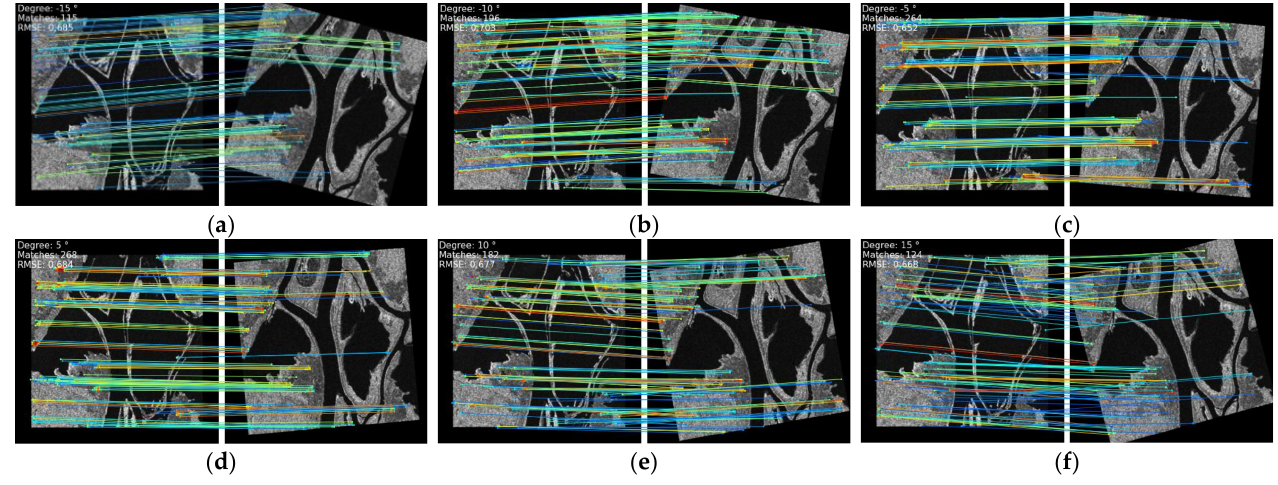
Figure 12. The registration performance of SAR images at varying rotations: ( a ) –15°, ( b ) –10°, ( c ) –5°, ( d ) 5°, ( e ) 10°, and ( f ) 15°.